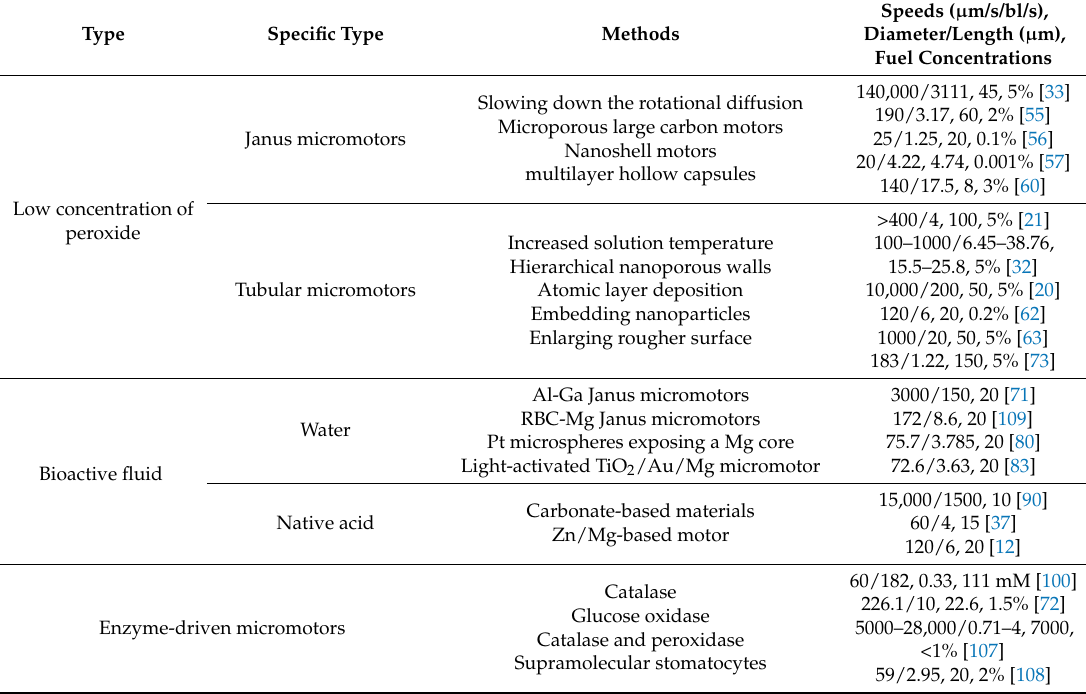
Table 1. A representative review of preparation methods and speed of fast bubble-driven micromotors in biocompatible fuel. An absolute speed is described as the criteria for fast micromotors. A concentration of 5% is regarded as the criteria for “Low concentration”. These motors reach a fast speed (>1 bl/s), and even a superfast speed (>10 bl/s), with an ingenious design. The unit of relative speed bl/s refers to body